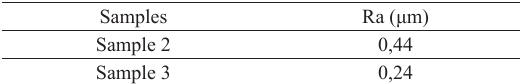
Figure 5. Micrographs of the samples that obtained the best results in absorbance and emittance. Table 5. Ra parameter of absorber